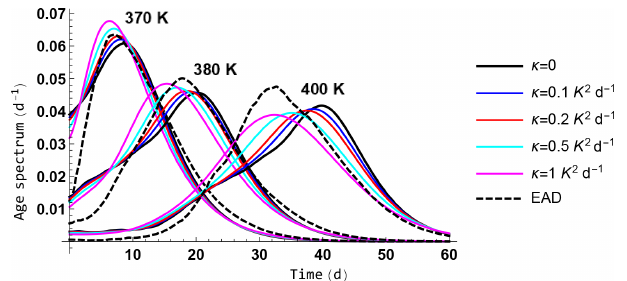
Figure 15. Solution of the Eq. (1) with the same set-up as in Fig. 14 for the diabatic ERA5 case. The normalized age spectrum is shown from left to right at 370, 380 and 400K for the inviscid solution ( κ = 0) and for four values of the diffusion κ : 0.1, 0.2, 0.5 and 1K 2 d − 1 as indicated in the legend. The normalized age spectrum for the 3-D trajectories (EAD) is shown as a